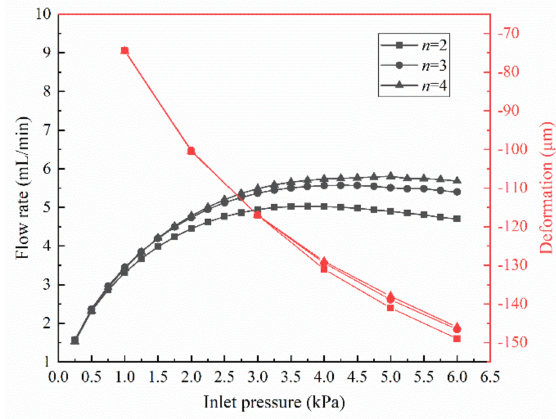
Figure 7. Flow rates and maximum deformation of the MPV with different numbers of microholes under varied inlet pressures ( L = 1000 µ m).